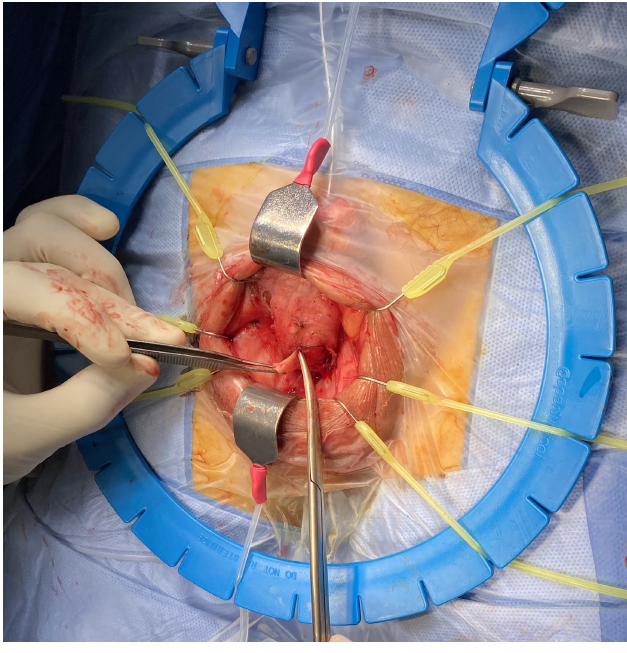
Figure 1. Bilateral corpora cavernosa flap harvesting.